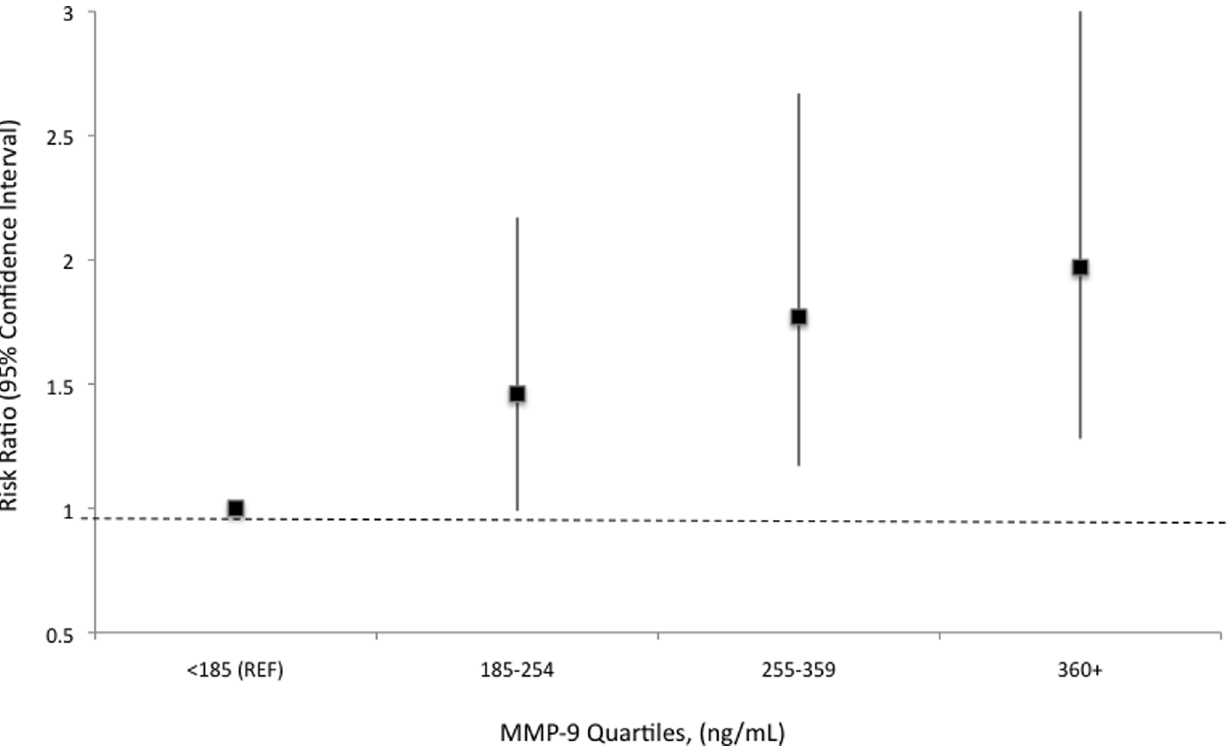
Figure 2. Association between quartiles of plasma matrix metalloproteinase-9 with incident atrial fibrillation in the Atherosclerosis Risk in Communities Study. The model is adjusted for age, sex, race, study site, education (high school degree vs. not), smoking (current vs. not), body mass index, physical activity, systolic blood pressure, diastolic blood pressure, use of antihypertensive medication, diabetes, C-reactive protein, NT-proBNP, prevalent coronary heart disease, prevalent heart failure and left ventricular hypertrophy.